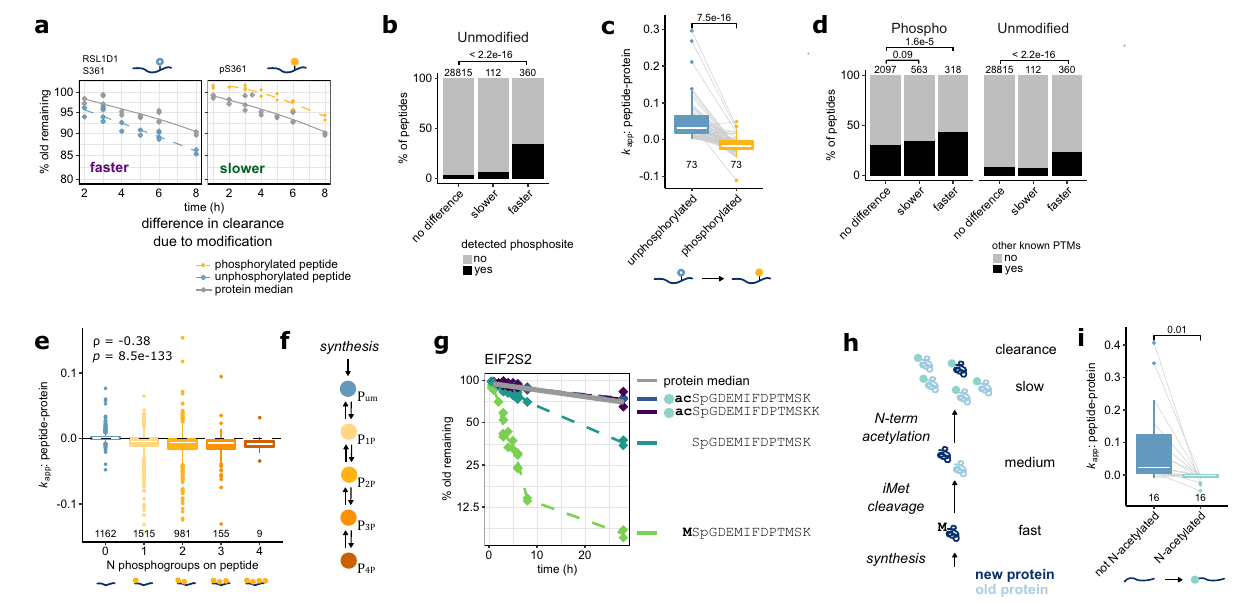
Fig. 3 | Peptide clearance rates reveal intermediates of protein modi fi cation. a ChangeinclearanceofaRSL1D1peptidecausedbyphosphorylationofS361.Left: fasterclearanceofaRSL1D1peptidecontainingunmodi fi edS361(blue,dashedline) compared to the medianof the rest of the unmodi fi ed RSL1D1peptides (gray, solid line). Right: slower clearance of a RSL1D1 peptide phosphorylated at S361 (yellow, dashedline). b Unmodi fi edpeptideswithfasterclearancearestronglyenrichedfor thesamepeptidealsodetectedinitsphosphorylatedform.Fisher ’ sexacttest,two- sided. c Initial clearance ( k app ) of peptides carrying phosphosites, where the unmodi fi ed form was identi fi ed as showing faster clearance and a phosphorylated form wasalso quanti fi ed.Shown are median values over replicates and peptides in case the same phosphosite was detected on multiple peptides. Paired, two-sided t test,( t -value=10.12,degreesoffreedom(df)=72). d Phosphorylatedpeptideswith faster clearance, and unmodi fi ed peptides with faster clearance are enriched for peptides carrying other known PTM sites (from Uniprot) suggesting that they represent early intermediates of protein modi fi cation cascades. Fisher ’ s exact test,